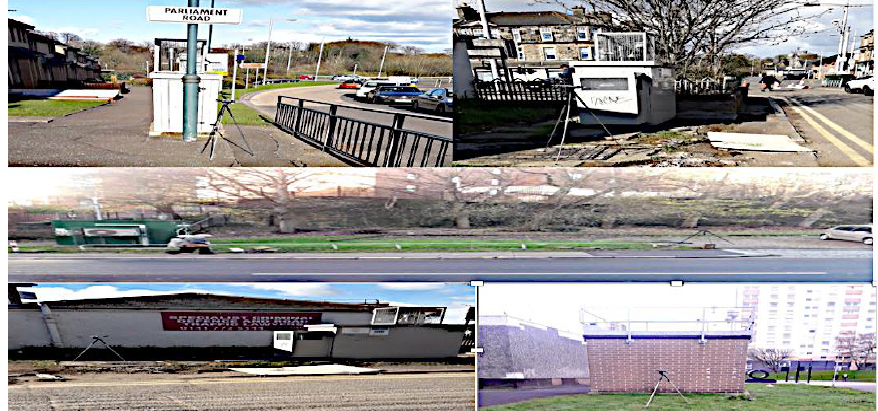
Figure 3. Position of sound meter and air monitor at monitoring sites.